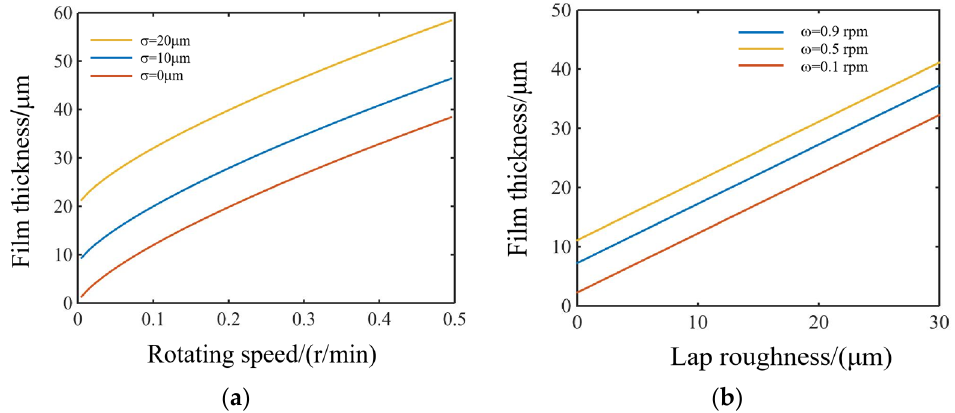
Figure 4. Influence of rotating speed and lap roughness on liquid film thickness. ( a ) Liquid film thickness vs. rotating speed ( b ) Liquid film thickness vs. lap roughness.